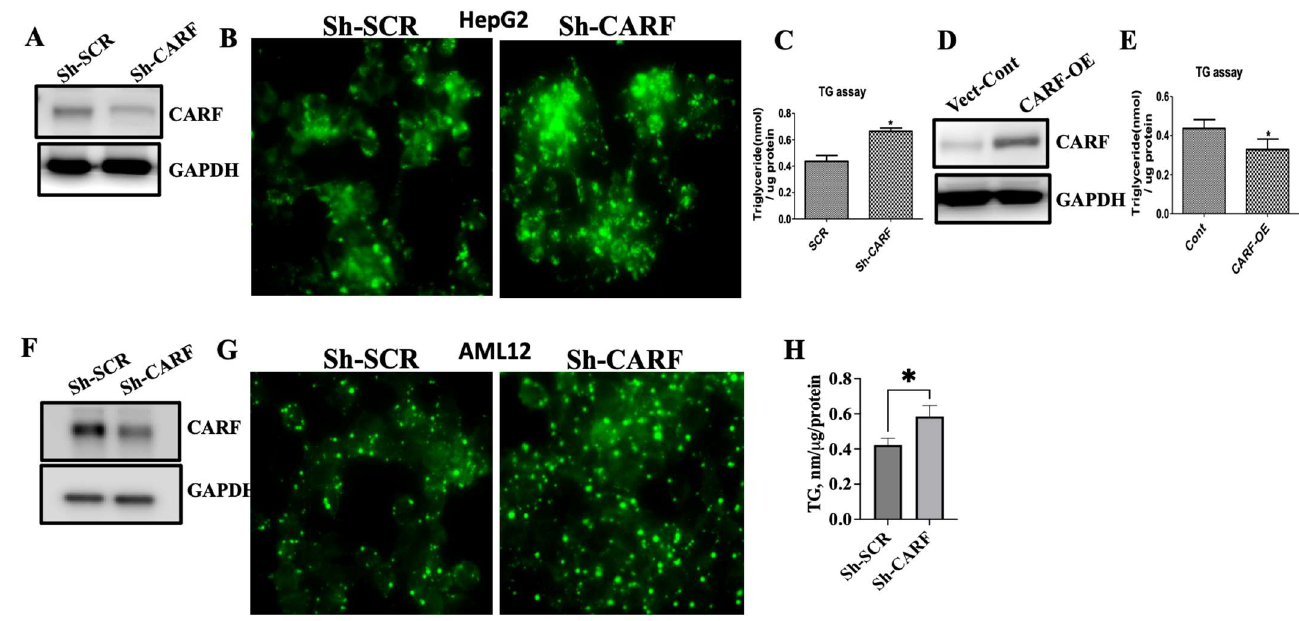
Figure 2. Modulation of CARF regulates lipid accumulation in HepG2 and AML12 cells. Western blot analysis shows CARF expression after Sh-RNA treatment in HepG2 cells ( A ) and AML12 cells ( F ). Fluorescent images of BODIPY-stained HepG2 cells ( B ) and AML12 cells ( G ). TG level after CARF silencing in triplicate cultures of HepG2 cells ( C ) and AML12 cells ( H ). Western blotting showing the overexpression of CARF in HepG2 cells ( D ) and the effect of CARF overexpression on TG accumulation in HepG2 cells from triplicate cultures ( E ). Parametric and unpaired Student’s t- test was used for comparison between the two groups. (* p < 0.05).